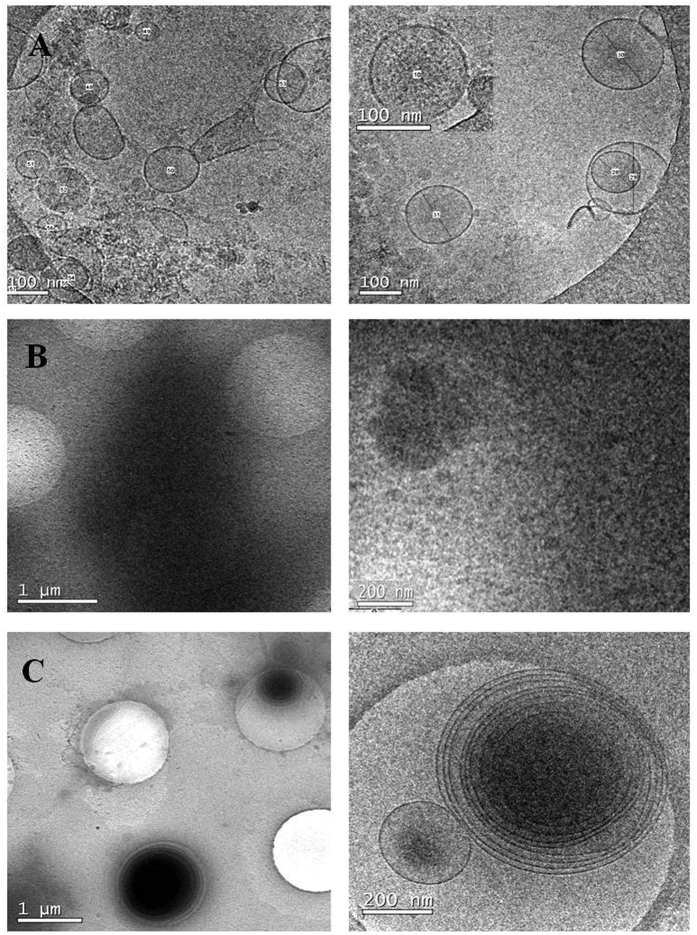
Cryo-EM images.(A) Pooled SEC fractions showed single vesicles of size between 80–200 nm. (B) No vesicles were found in Cryo-EM images from PEG precipitated samples. Electron dense particles covered the whole grid indicating co-precipitation of contaminants. (C) PROSPR isolated vesicles were visualized as concentric multi-layered vesicles, mostly measuring from 300 to 500 nm. Scale bars are shown for each image.